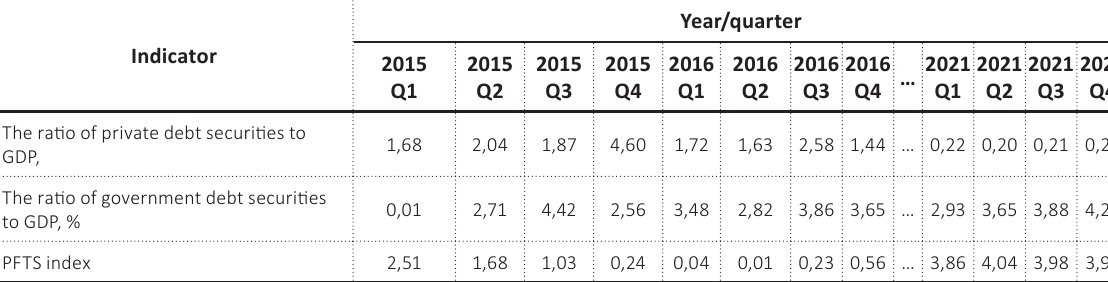
Table А8. Normalized values for indicators of Ukraine’s stock market security characteristics